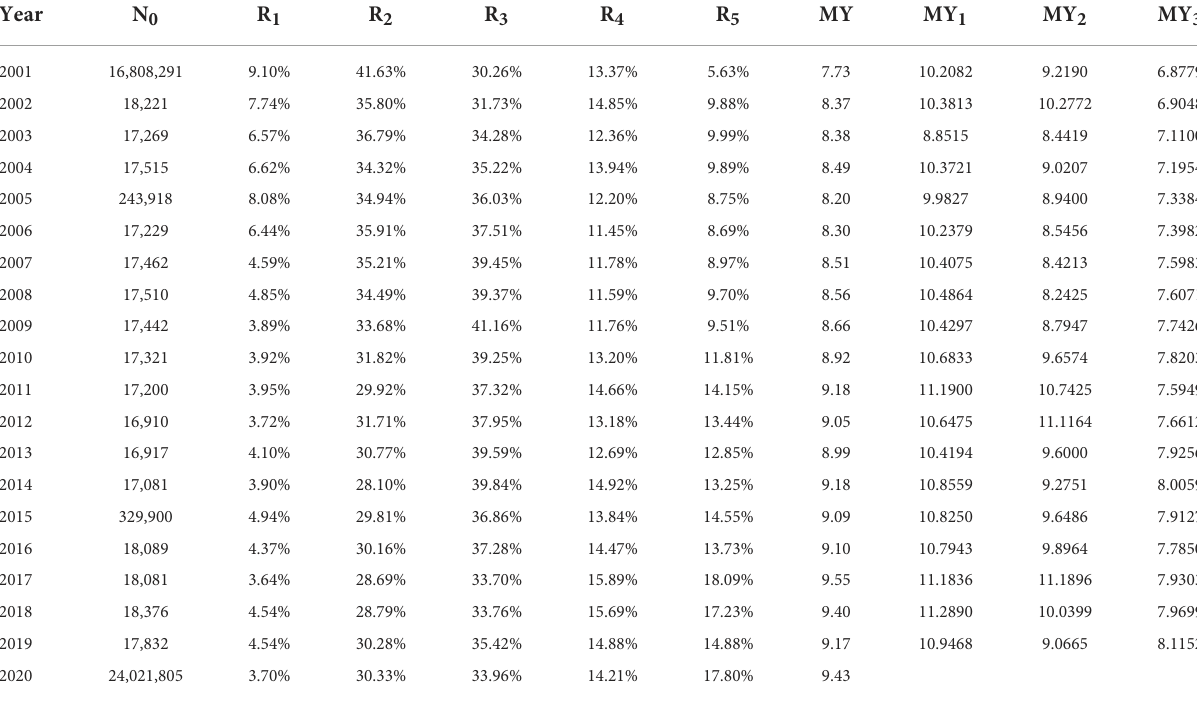
TABLE 4 Basic situation of education development in Xinjiang since